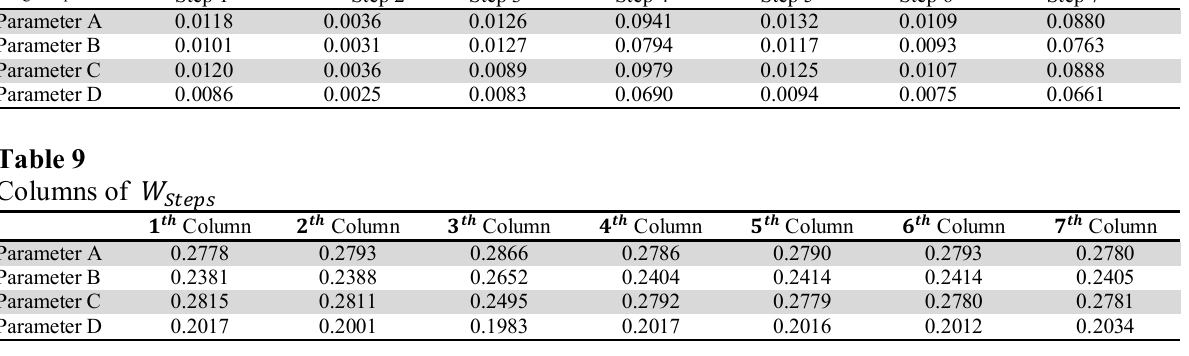
Table 8 is the priorities in PRs in seven level of improvement affected by how costly the steps are. Based on the methodology the columns of (cid:1849) affected by cost rates of the steps in table 7 (cid:1849) (cid:3002)(cid:3015)(cid:3017) (cid:3268)(cid:3254)(cid:3266) Weighted